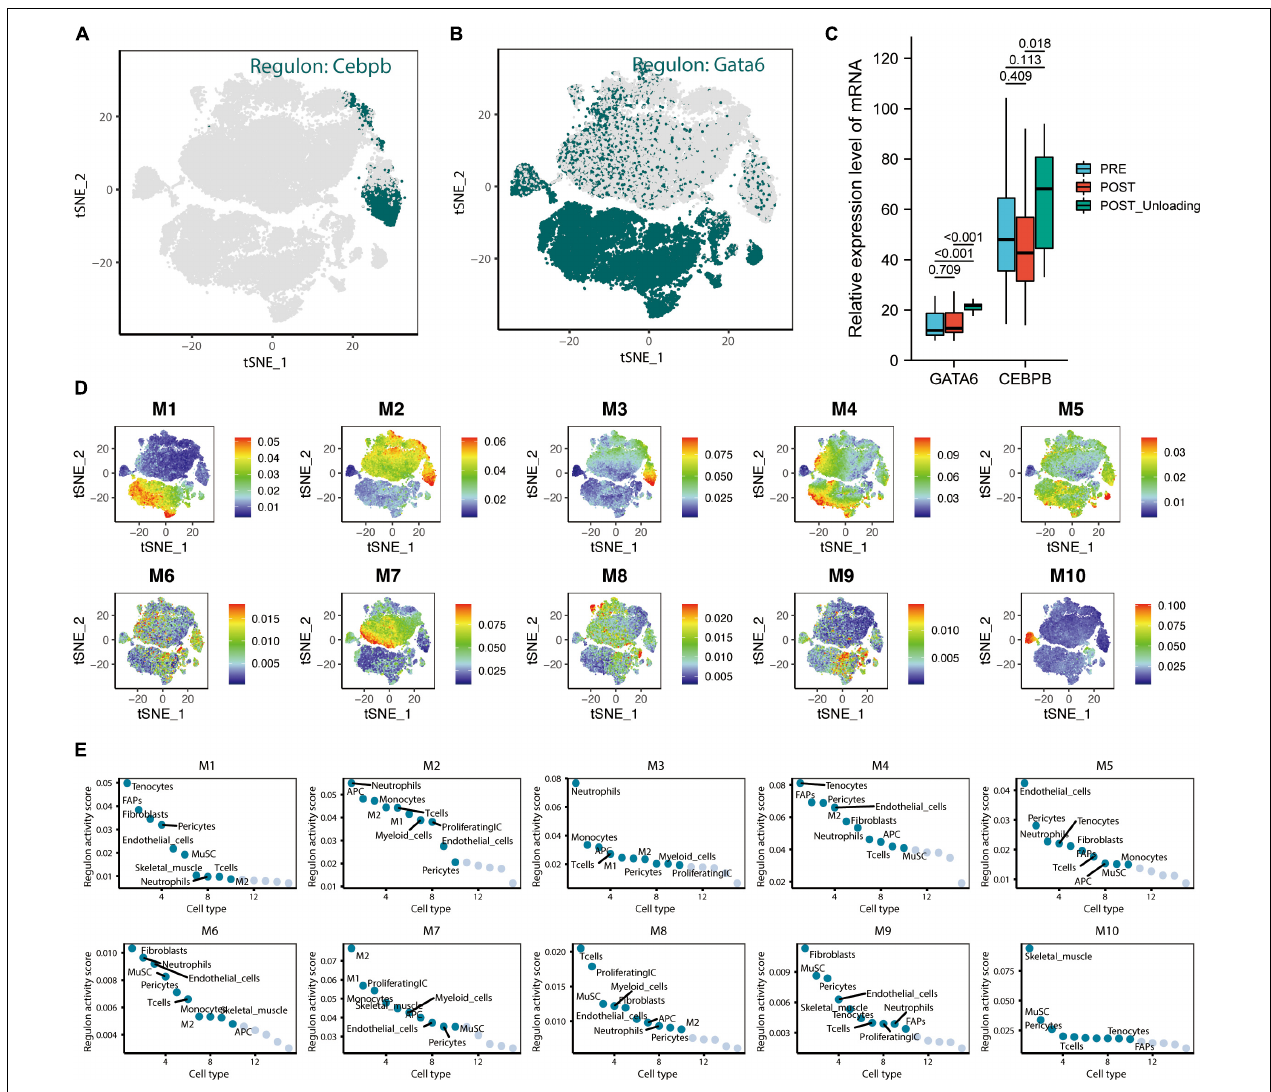
FIGURE 6 | CEBPE and GATA6 were defined as potential transcriptional regulators leading to the upregulation of hsa-miR-215 expression and analysis of skeletal muscle single-cell transcriptional regulatory module. (A) tSNE plot demonstrating the expression characteristics of regulon CEBPB in single cells. (B) The tSNE plot demonstrates the expression characteristics of regulon GATA6 in single cells. (C) Expression characteristics of GATA6 and CEBPB in the pre-loading (PRE), post-loading (POST), and de-loading groups (POST Unloading) in the GSE155933 dataset, with p -values < 0.05 defined as significant differences. (D) The average expression characteristics of genes in each module are shown on the tSNE plot. (E) Plot of ranking distribution of individual cells in each module according to the regulon activity